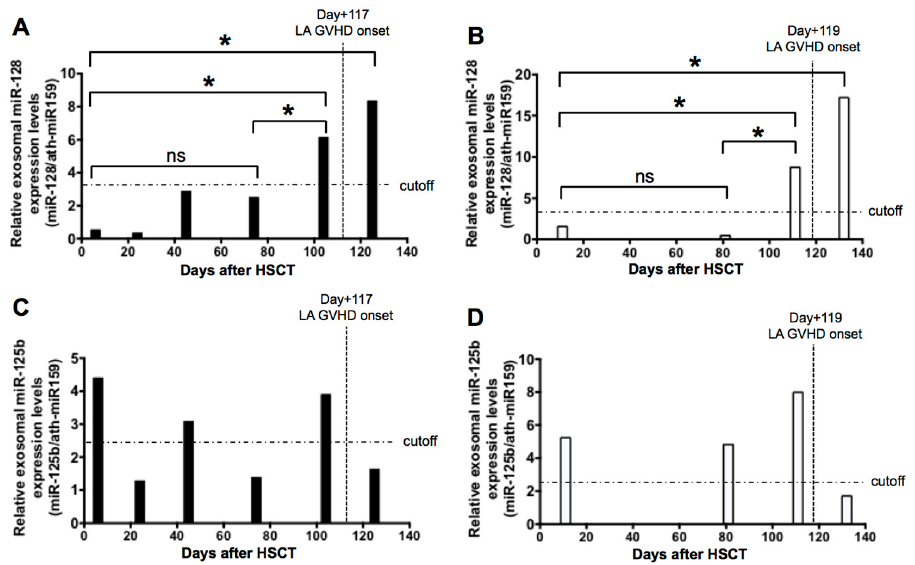
Figure 6. Bar graphs show relative expression levels of each miRNA at each time point after HSCT.